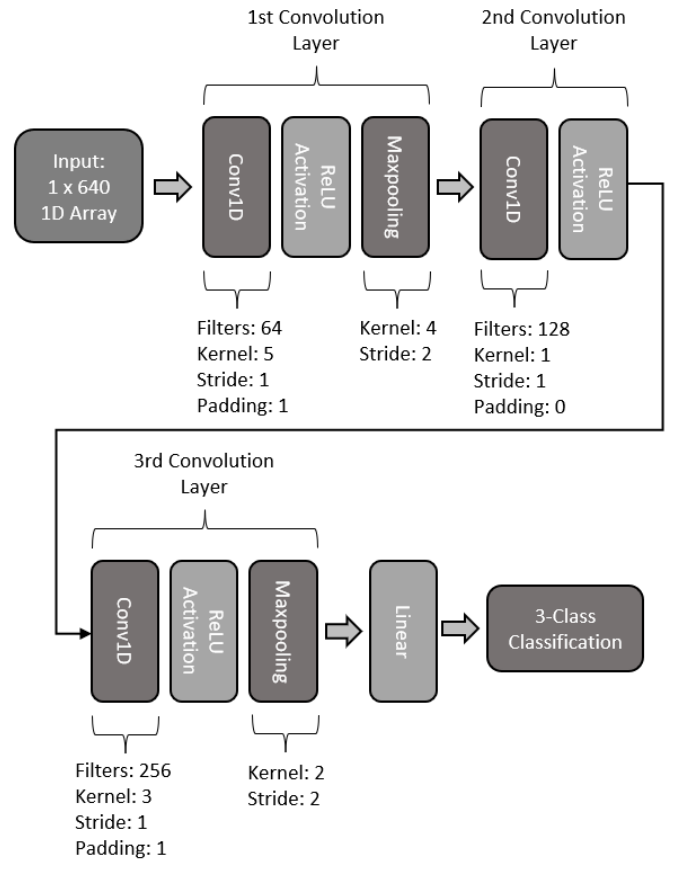
Figure 17. Architecture of three-layer 1D CNN